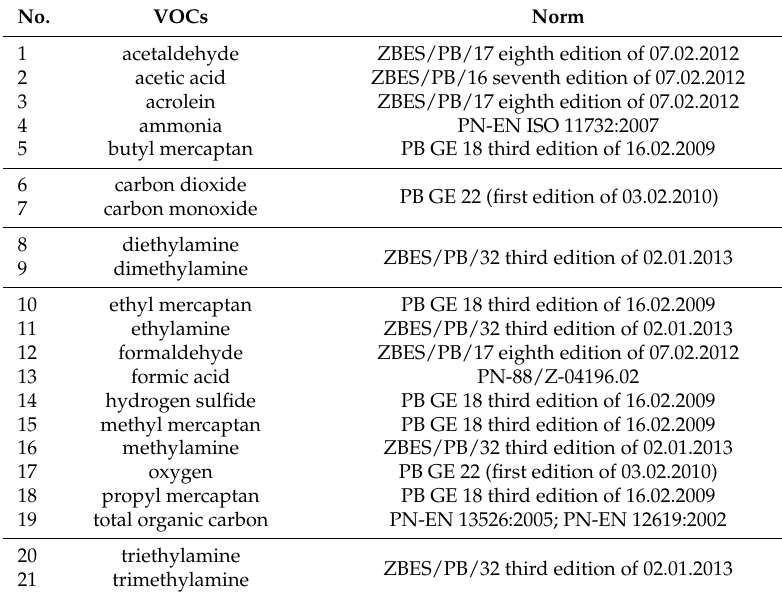
Table 3. Detection